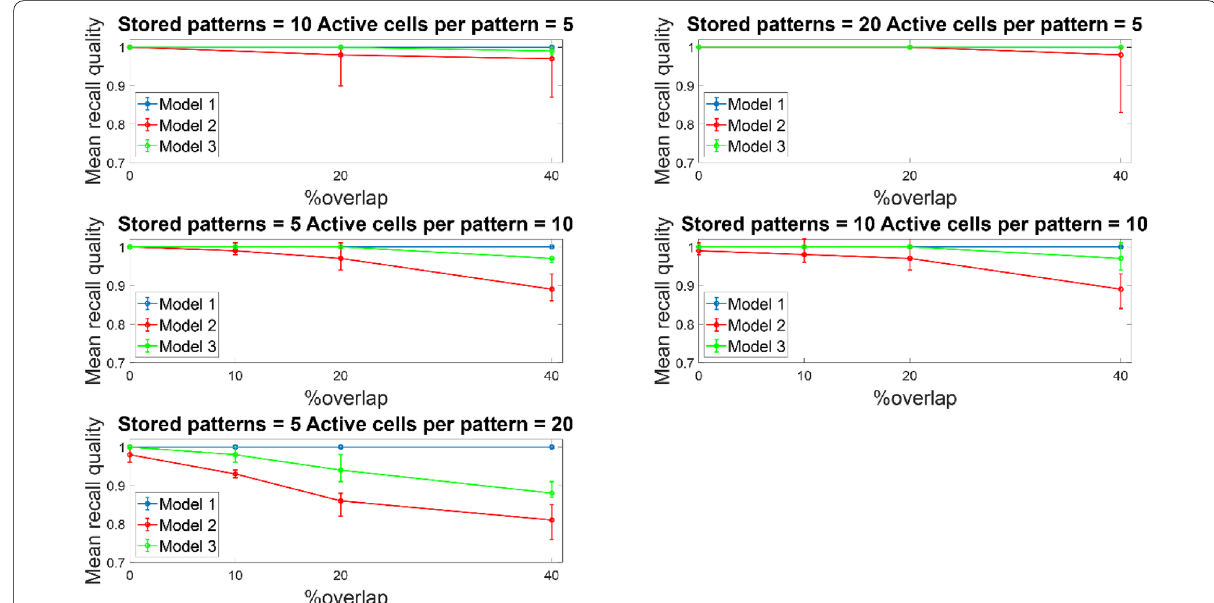
Fig. 7 Mean recall quality of ‘model 1’, ‘model 2’, and ‘model 3’ as a function of percent overlap (0%, 10%, 20%, 40%). Each model was a network of 100 PCs, 1 BSC and 1 OLM